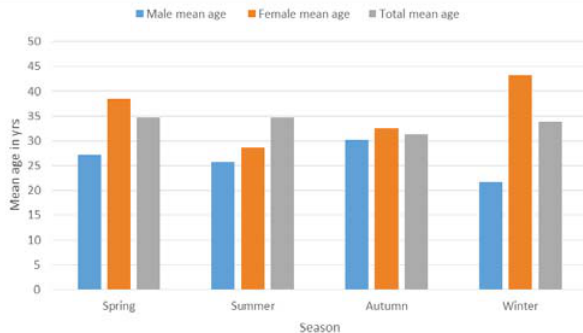
Figure 8. Patient distribution according to mean age of